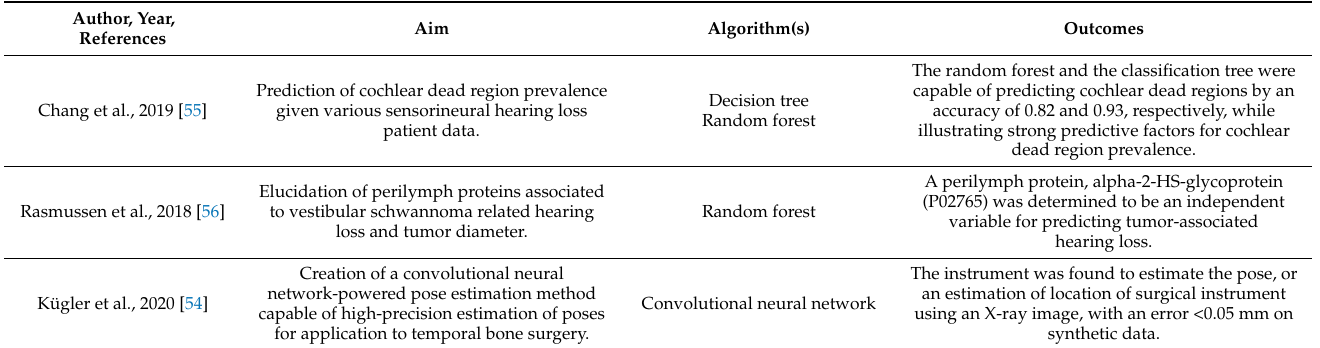
Table 4. Summary of the manuscripts with machine learning applications in other